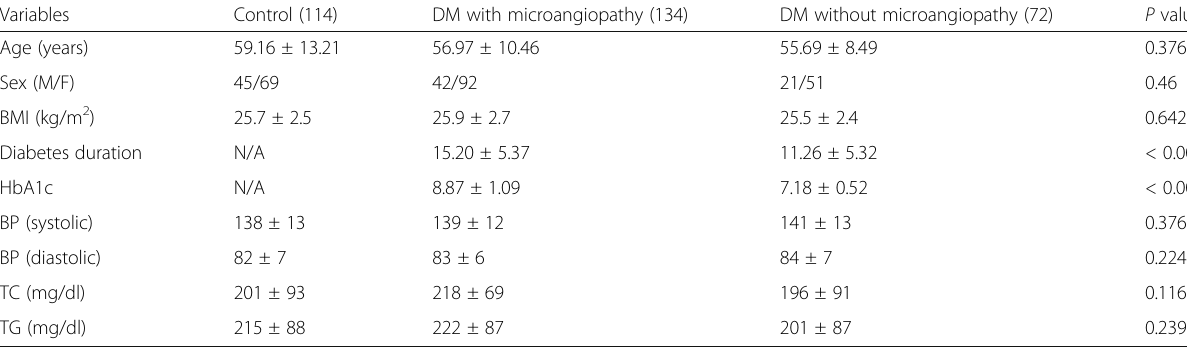
Table 2 Clinical characteristics of the study population Variables Control (114) DM with microangiopathy